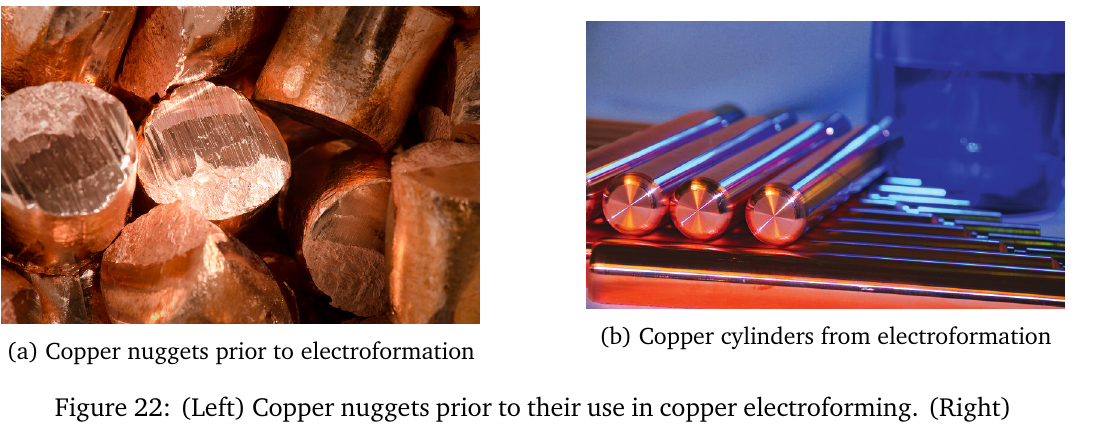
Figure 22: (Left) Copper nuggets prior to their use in copper electroforming. (Right) Copper cylinders resulting from the electroformation process. The blue solution in the background is copper sulfate from the electroforming bath in which these copper pieces were grown. Image provided by PNNL researchers Eric Hoppe, Brian LaFer- riere, Jason Merriman and Nicole Overman and made available courtesy of Pacific Northwest National